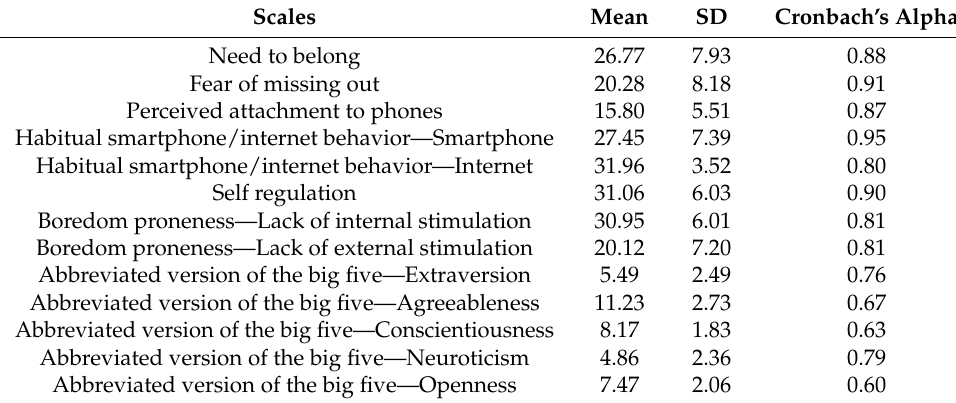
Table 1. Statistics of the psychosocial